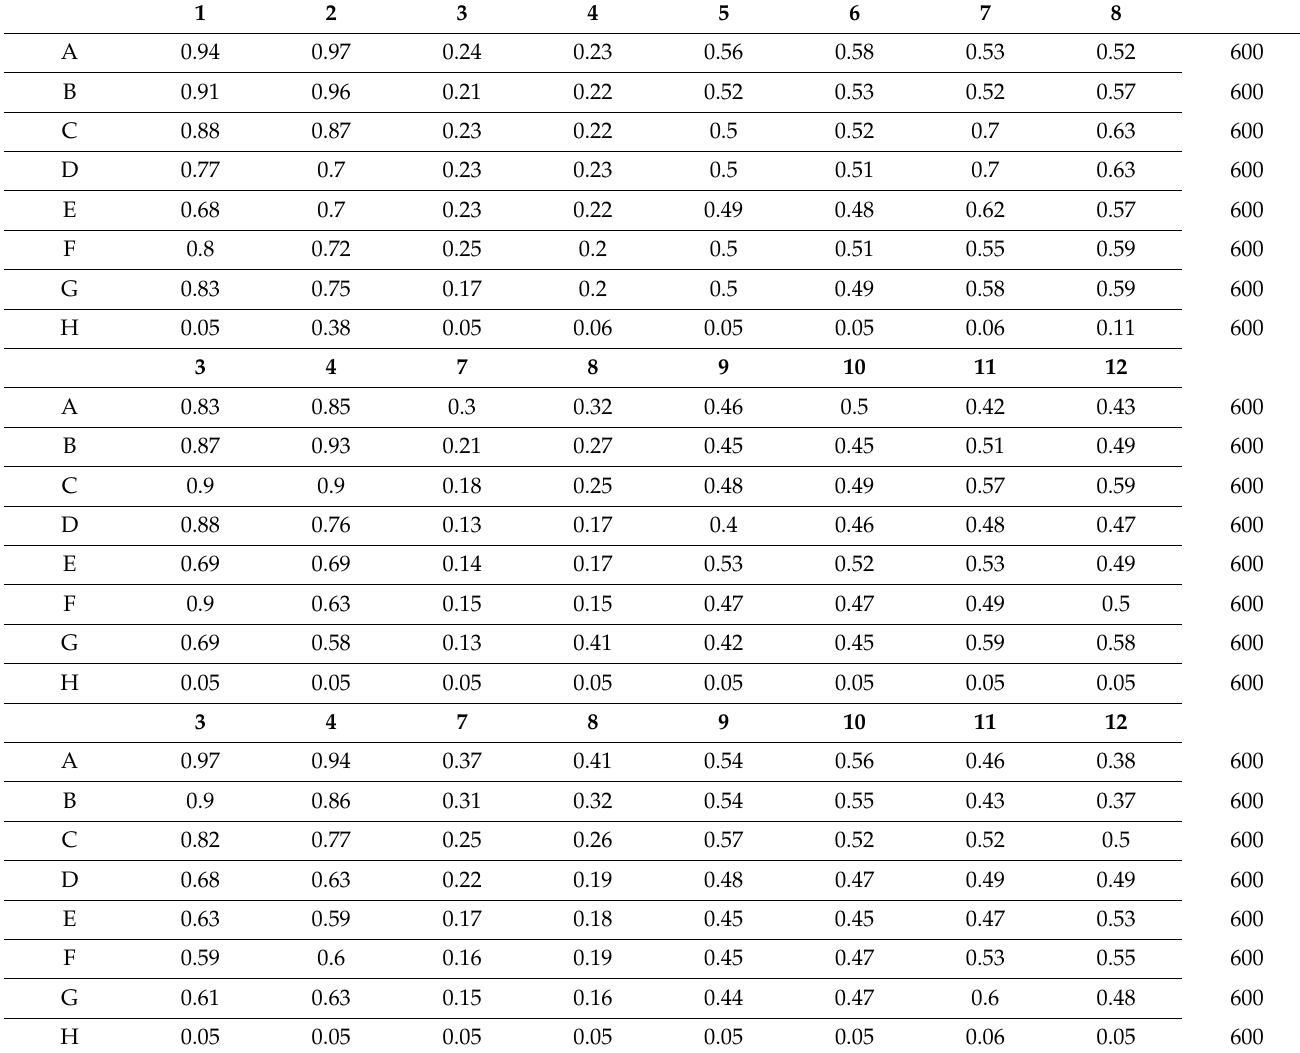
Table 3. OD values for bacterial strains Pseudomonas aeruginosa ATCC 10145 (1–2), Listeria monocy- togenes ATCC 13932 (3–4), Bacillus cereus ATCC 11778 (5–6), and yeast Candida albicans ATCC 10231 (7–8) treated with 25 GQD IPA -EDA (top), 50 GQD IPA -EDA 50 (middle), and 200 GQD-1EDA